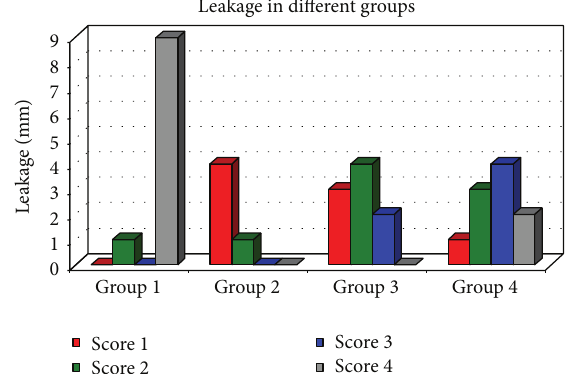
Figure 2: Frequency of microleakage scores in different groups.